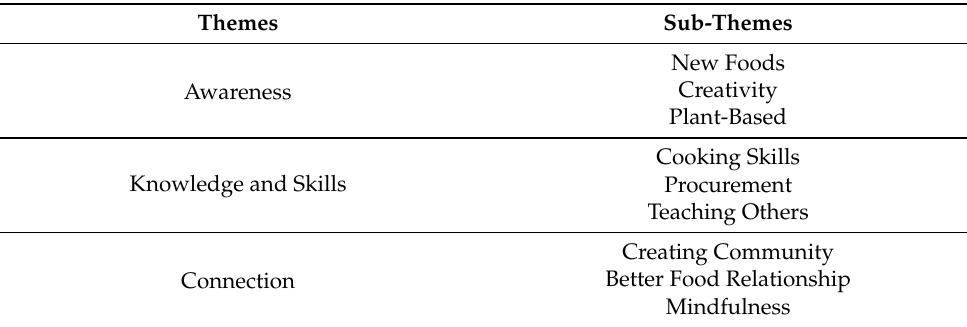
Table 3. Experiences described by Food Next Door (FND) undergraduate student volunteers (n = 8) in year